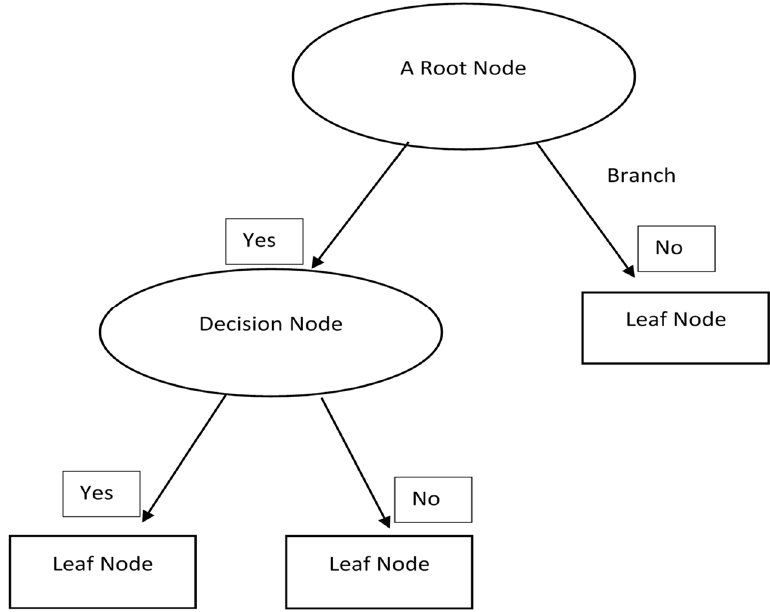
Figure 3. A sample random forest decision tree structure.